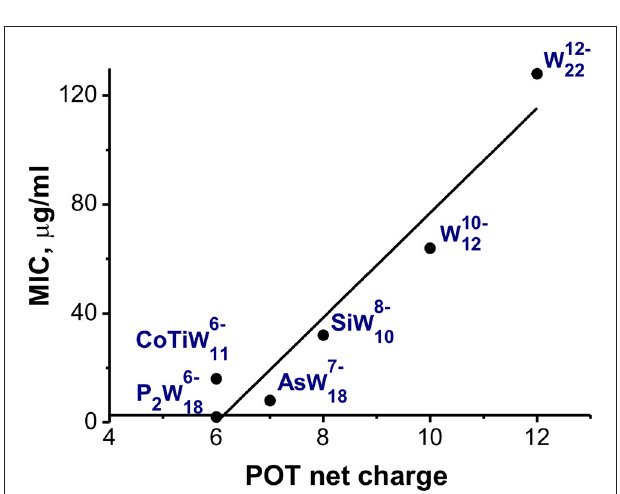
TABLE 3 | Dimension and redox characteristics for phosphorus-containing Keggin, Dawson, and Preyssler POTs. POT Charge number ( z ) Volume/10 − 22 cm 3** Volume charge density/cm − 3** z / m * Reduction potential, V** MIC, µ g/ml P 5 W 14 − 30 (Preyssler) − 14 18.48 1,213 0.47 − 0.43 1 P 2 W 6 − 18 (Dawson) − 6 9.995 961.8 0.33 + 0.06 2 PW 3 − 12 (Keggin) − 3 6.234 771.0 0.25 − 0.023 128 * m-number of addenda atoms. ** were taken from López et al. (2006).